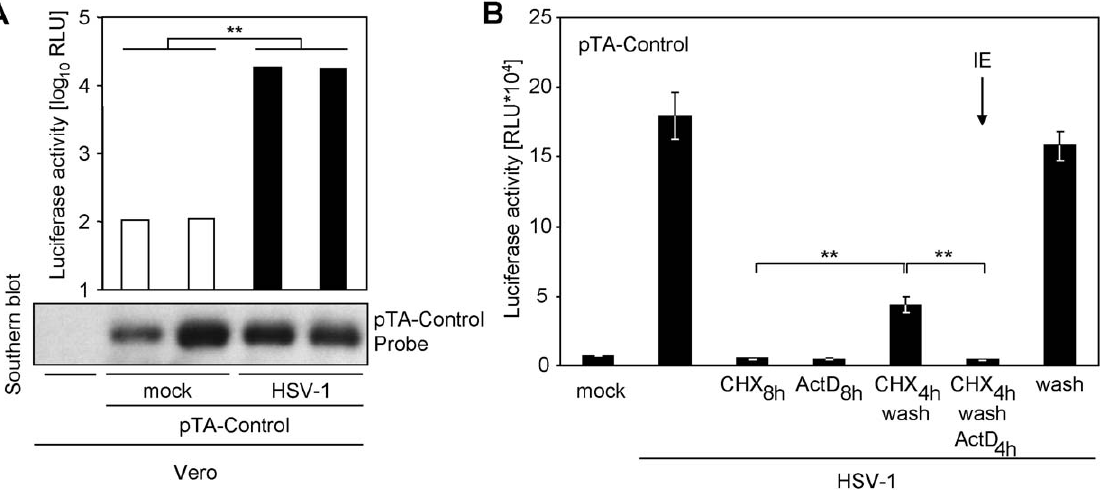
Figure 5. HSV-1 induces a bona fide transactivaion of the pTA-Control promoter. ( A ) Vero cells were transfected with the pTA-Control plasmid. The cells were split and infected with HSV-1 F strain. 24 h p.i. the expressed luciferase activity was measured. The cells were lysed and DNA was extracted in parallel, separated on an agarose gel and used for a Southern blot. The membrane was probed with DIG labelled (DIG high prime, Roche) pTA-Control plasmid. ( B ) CV-1 cells were transfected with 700 ng of the pTA-Control vector. Cells were infected with 10 PFU/cell HSV-1 F strain. Cells were incubated for 4 h with cycloheximide (CHX), which was replaced by 5 m g/ml actinomycin D (ActD) 4 h p. i. for selective immediate early protein expression conditions. Absence of ActD following washing (fifth bar f. l.) documents reversibility of CHX and continuous CHX and ActD treatment served as control for drug efficacy. Cells were lysed and luciferase activity was determined.